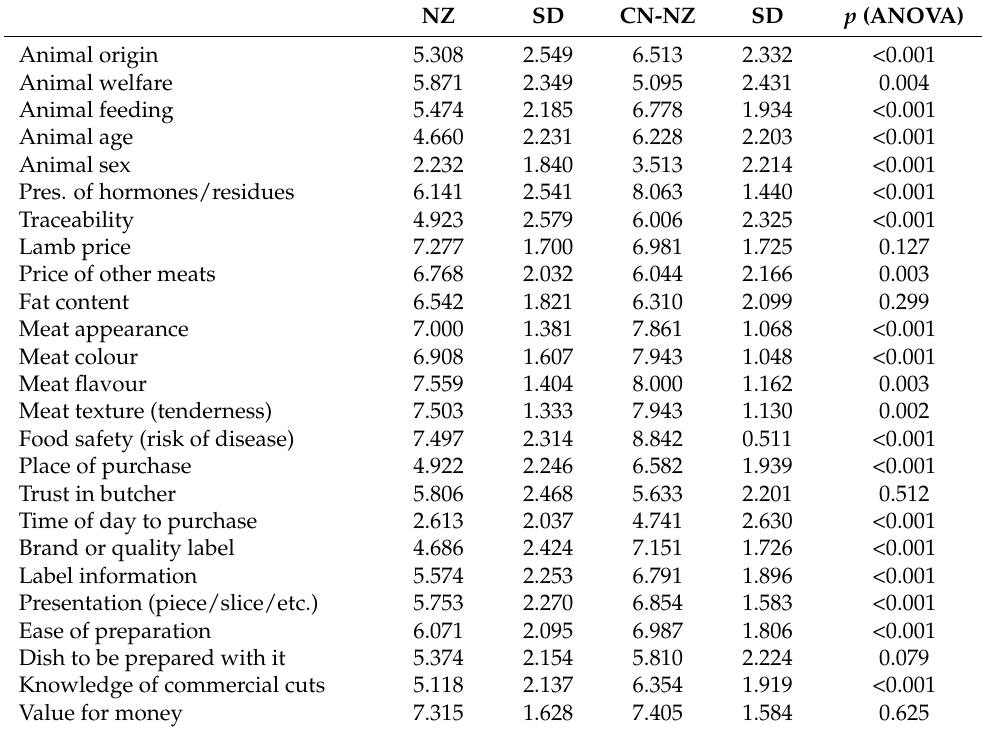
Table 4. The relative importance of lamb attributes at the point of purchase for New Zealand consumers and Chinese consumers (mean ± SD) (1 = not important, 9 = very important) ( p value determined using ANOVA with ethnicity as main